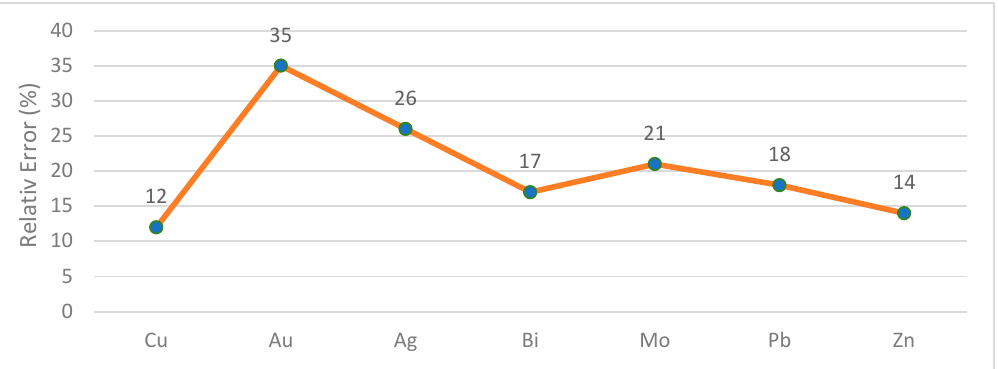
Figure 3. Relative error diagram of duplicate samples in stream sediment analysis [35].